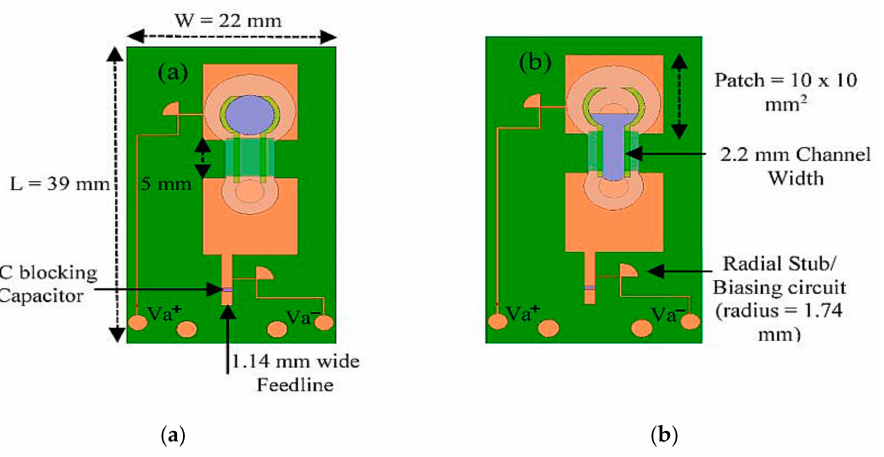
Figure 9. Dual patch antenna. ( a ) OFF configuration. ( b ) ON configuration